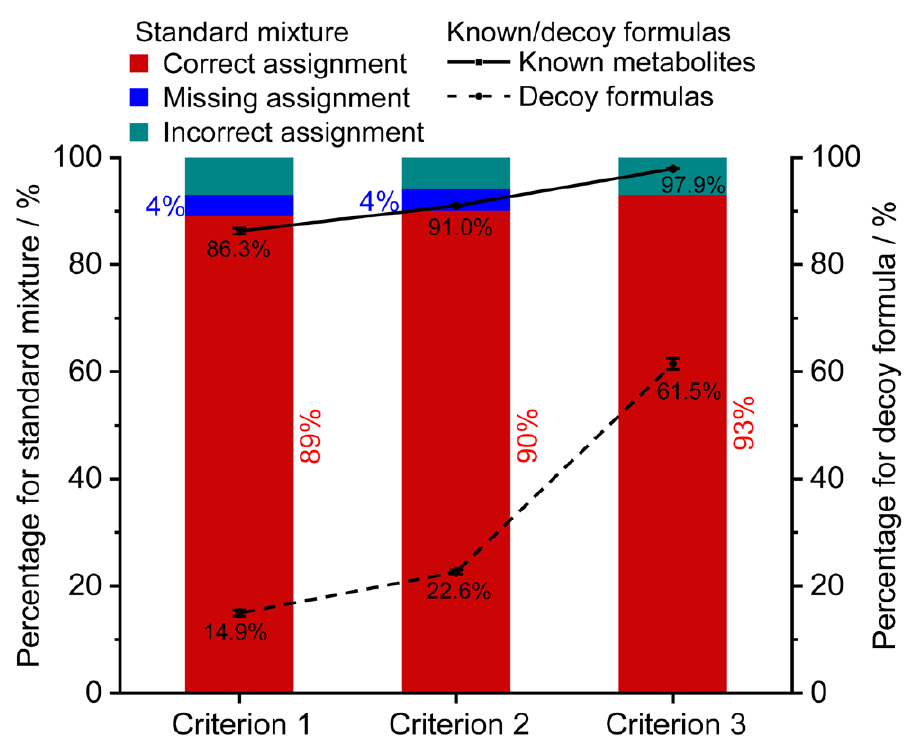
Figure 3. The effects of the initial networks on the assignment performance. The formula assignment results of the standard mixture (stacked column), 1000 blood metabolites (solid line), and 1000 decoy formulas (dash line). Criterion 1, 2, and 3 represent the initial network constructed by 1650 endogenous formulas from blood, 5620 endogenous formulas, and all the 12,351 formulas in the HMDB database, respectively. Error bars represent ±SE ( n = 3).